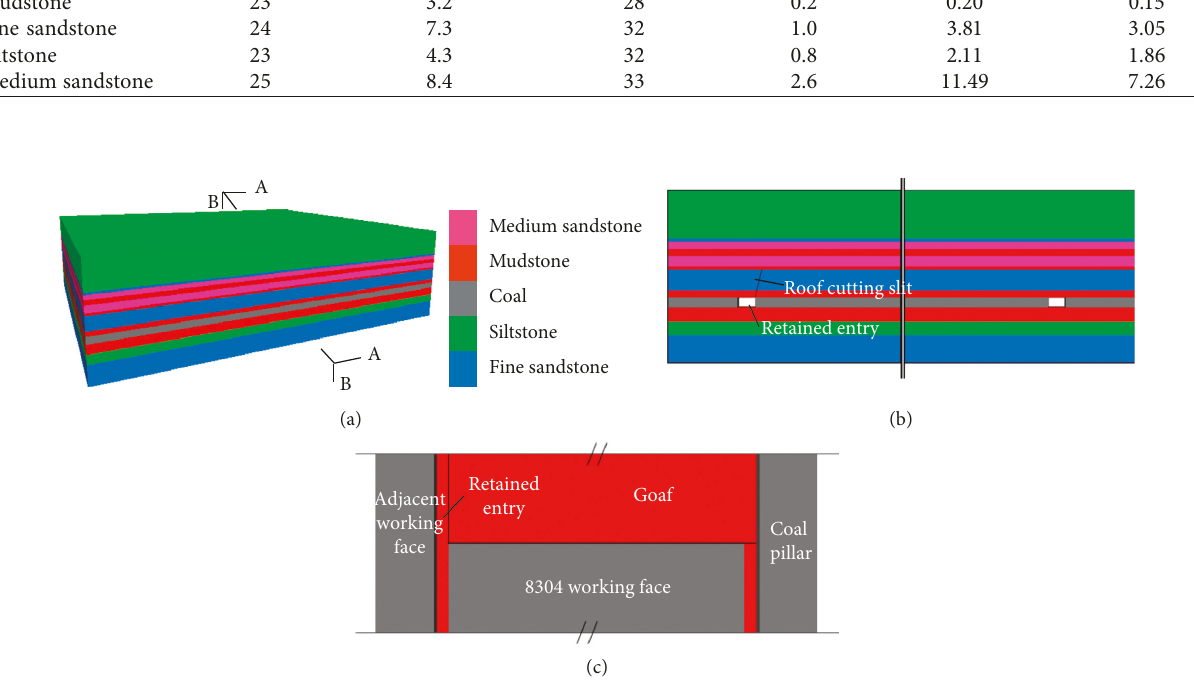
Figure 4: Typical numerical calculation model: (a) 3D model, (b) Section A-A, and (c) Section